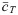
a) Traces of the cytosol and SR calcium concentrations for three different values of total calcium concentration c¯T. b) Oscillation periods as a function of c¯T. The strength of the noise is σ = 2 ⋅ 10−3.